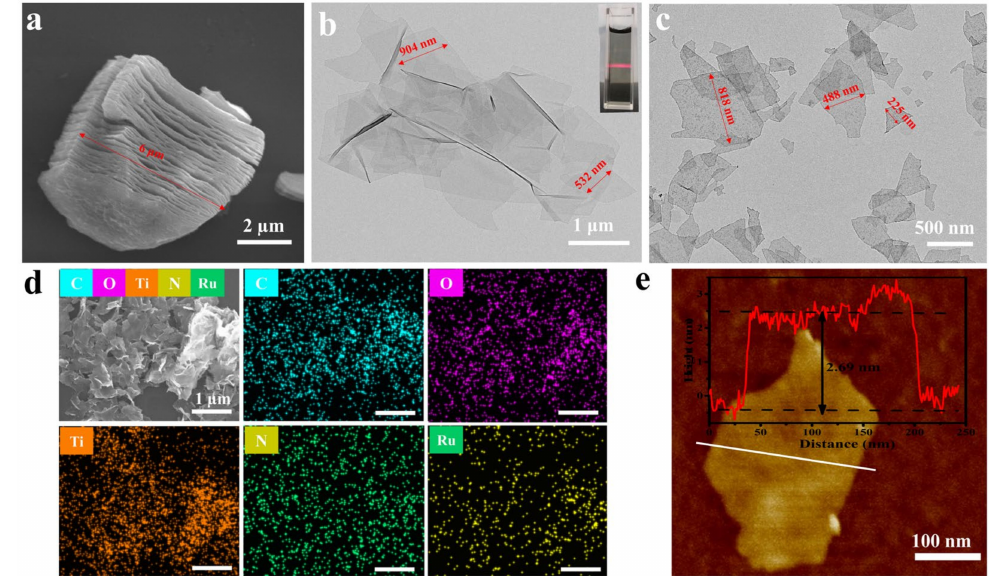
Figure 3. ( a ) SEM micrographs of multilayered Ti 3 C 2 T x . ( b ) TEM images of single-layer Ti 3 C 2 T x nanosheets. Inset shows a digital photo of Ti 3 C 2 T x nanosheets dispersed in water exhibiting the Tyndall effect when a red laser beam was used. ( c ) TEM images of Ru@MXene. ( d ) SEM images of Ru@MXene and corresponding elemental mapping. ( e ) AFM views of single-layer Ti 3 C 2 T x